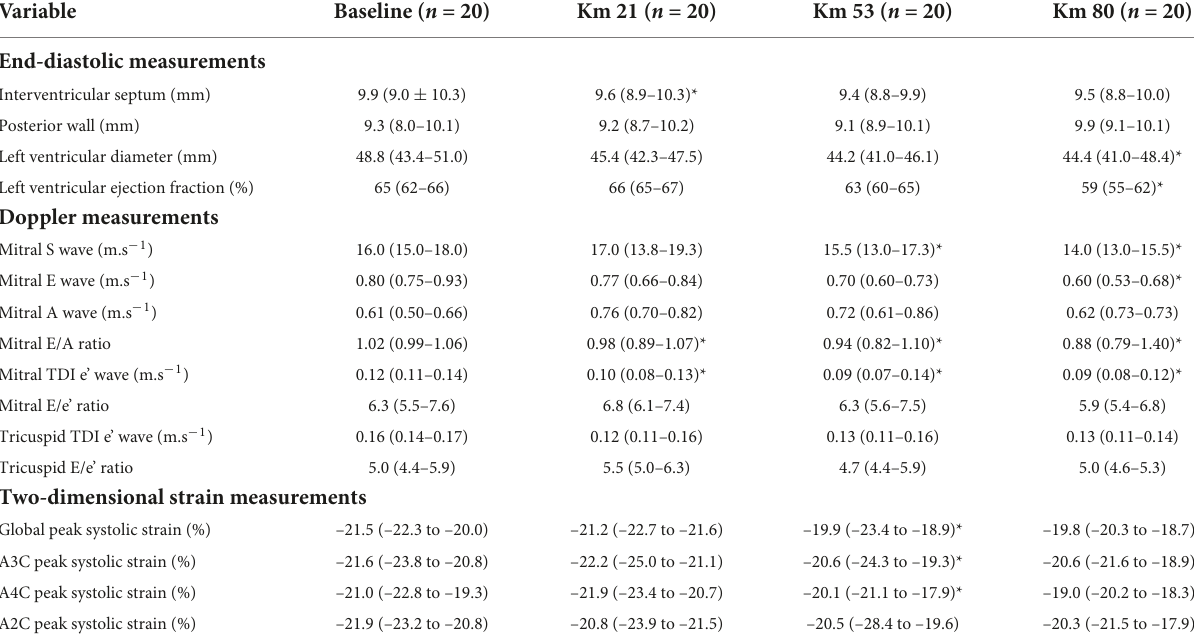
TABLE 2 Echocardiographic characteristics of the 20 amateur ultra-distance and trail